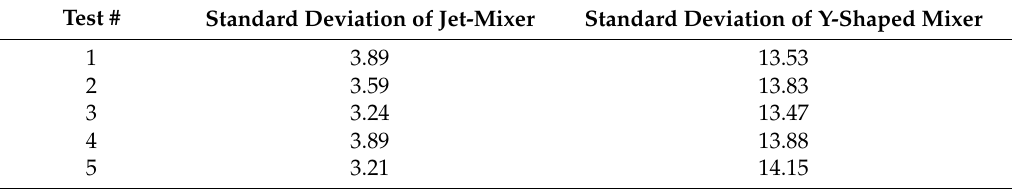
Table 2. The standard deviation value of the Y-shaped and the jet mixer under di ff erent numbers of the